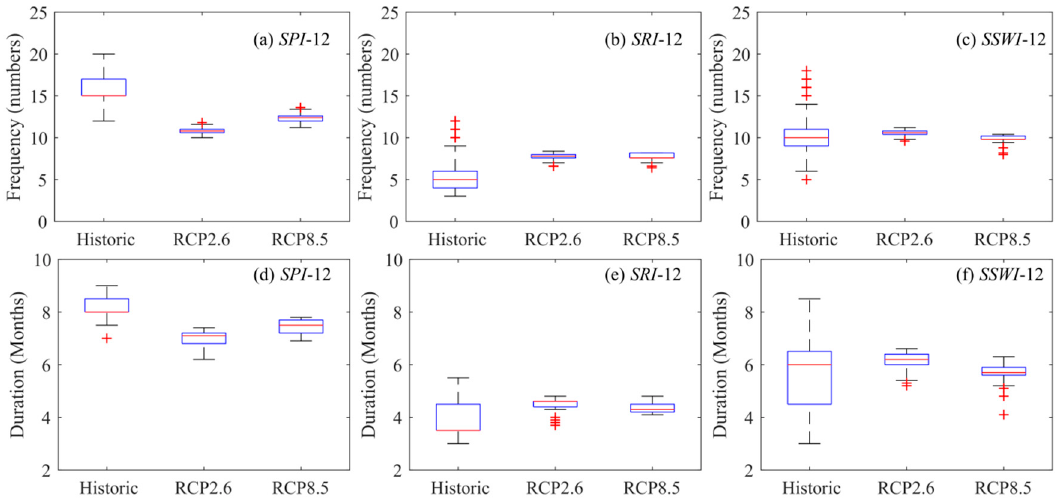
Figure 4. Comparison of the frequency and duration of historic and future of ( a , d ) SPI -12, ( b , e ) SRI -12, and ( c , f ) SSWI -12 droughts based on an ensemble of five GCMs. The red lines inside the boxes show the median, the boxplots show the 25 and 75 percentiles, and the whiskers show 5 and 95 percentiles from 333 subbasins in KRB.